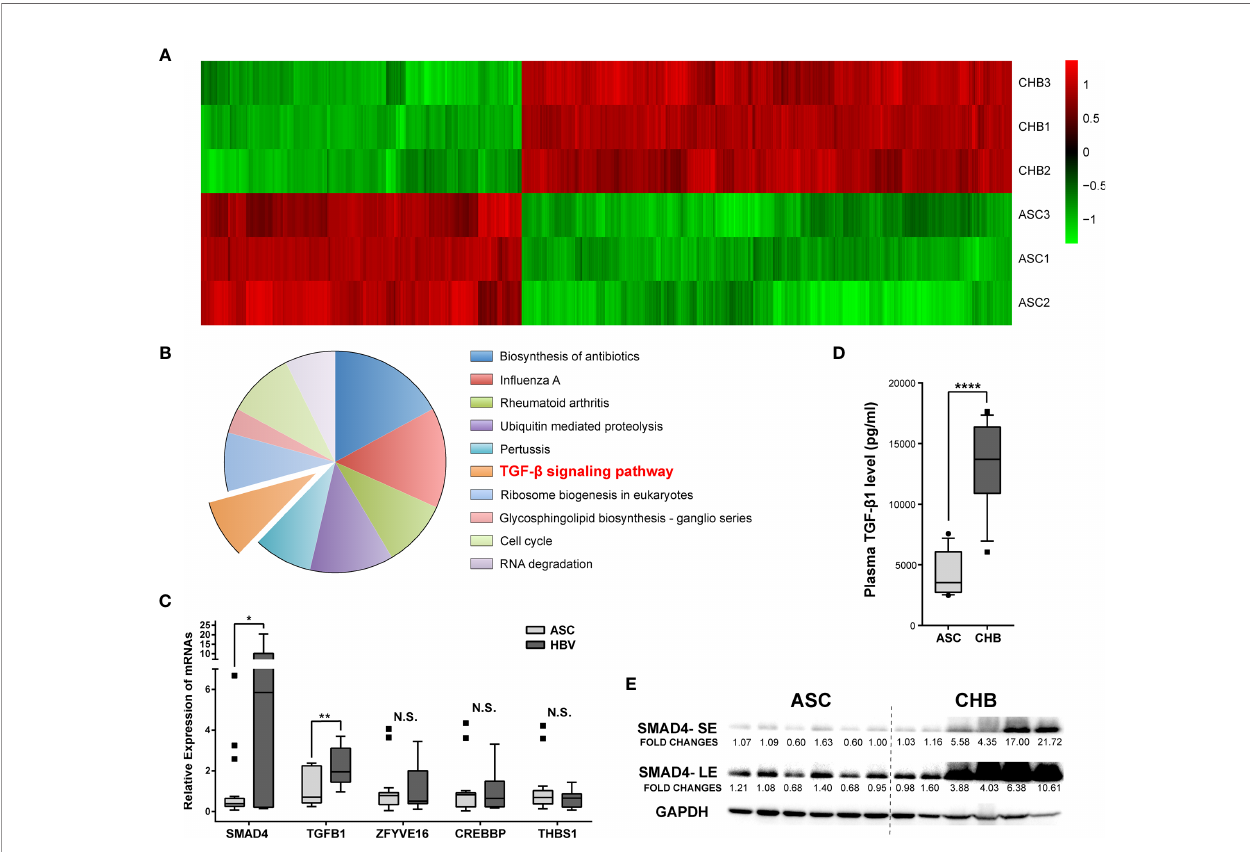
FIGURE 1 | Expression differences and enrichment analysis of mRNAs in asymptomatic carrier (ASC) vs. chronic hepatitis B (CHB) samples with long-term antiviral treatment. (A) Hierarchical clustering analysis of 1,042 differentially expressed mRNA transcripts between CHB with long-term antiviral treatment and ASC samples (fold change >2, up- or down-regulated). Columns represent each gene, and rows represent each sample. The relative expression levels of mRNAs are depicted into color scale ranging from green (down-regulated) to red (up-regulated). (B) Pie charts of top ten enriched KEGG pathways including 630 up-regulated mRNA transcripts. (C) Quantitative real-time PCR validation of de-regulated genes from TGF- b signaling pathway in 18 ASC or 12 CHB samples. N.S., not signi fi cant, p > 0.05; ∗ p < 0.05; ∗∗ p < 0.01. (D) ELISA based serum levels of TGF- b in ASC or CHB samples. ∗∗∗∗ p < 0.0001. (E) Western blotting analysis of SMAD4 protein levels in ASC or CHB samples. SE, short-time exposure; LE, long-time exposure. Chemiluminescent densities were normalized with GAPDH, and fold changes were calculated based on the average densities of ASC